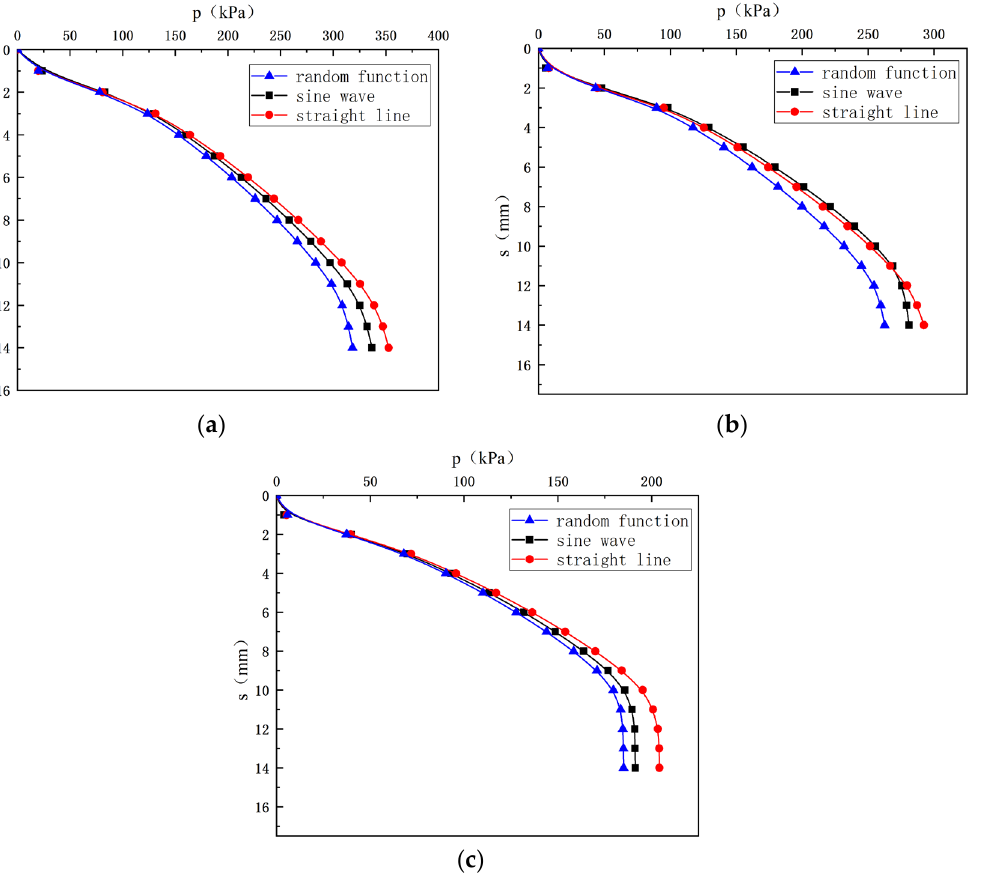
Figure 12. The p–s curves under different forms of water-level fluctuations: ( a ) 50 mm water level, ( b ) 100 mm water level and ( c ) 150 mm water level.